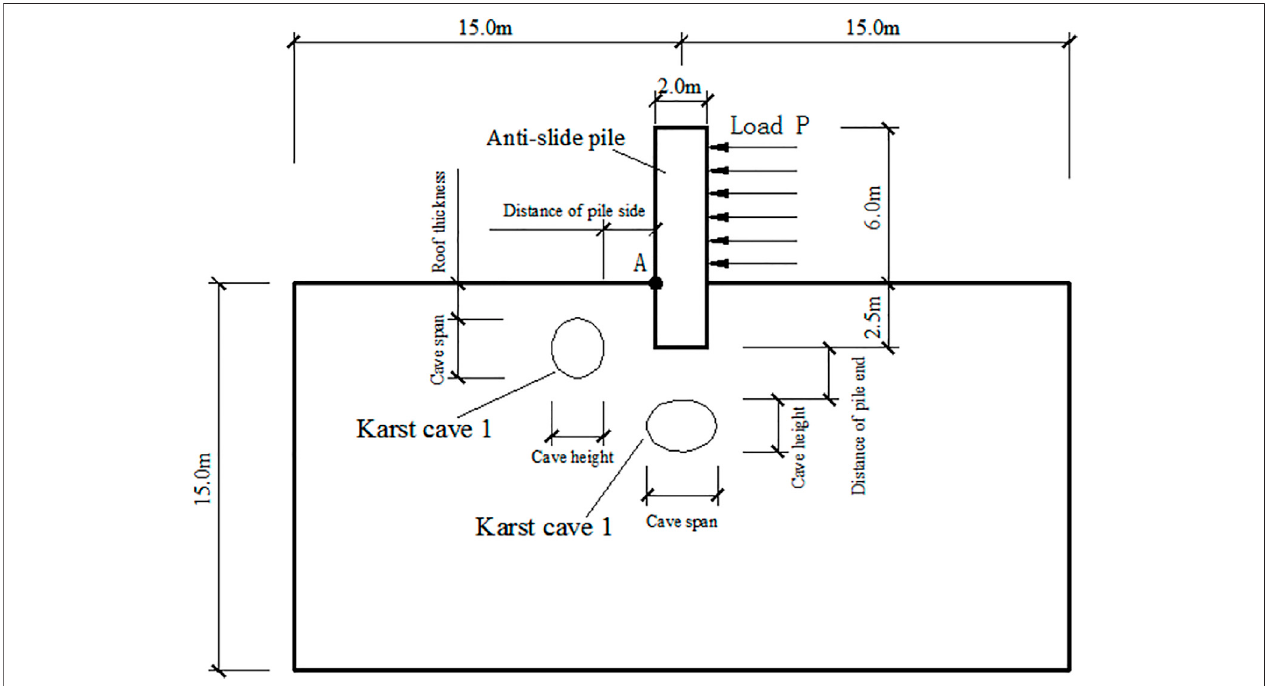
FIGURE 3 | Diagram of the loading model used in the simulations.